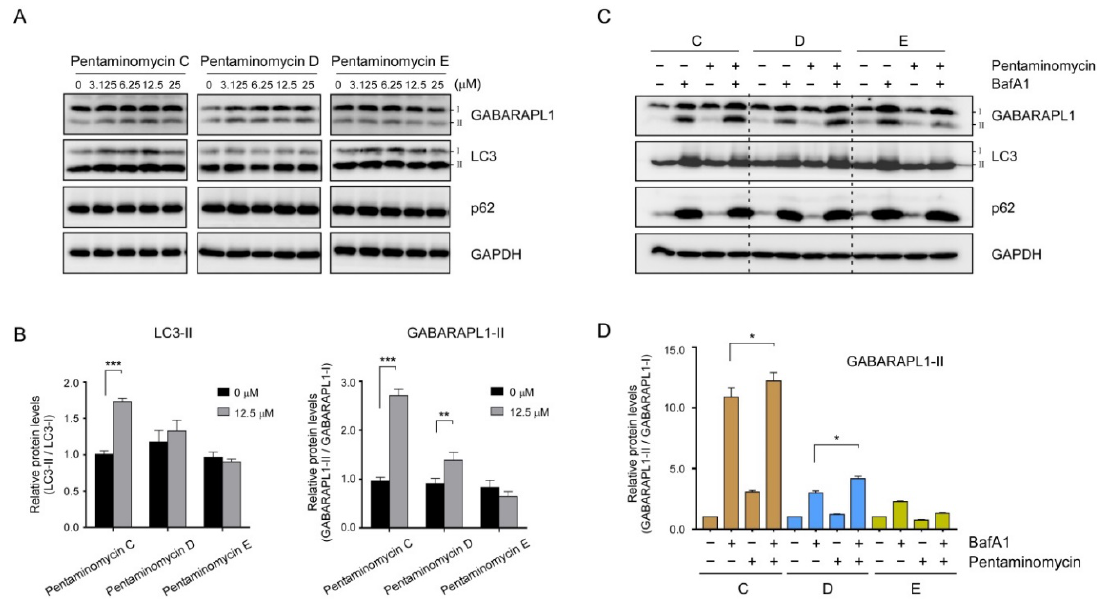
Figure 4. Effects of pentaminomycins C–E ( 1 – 3 ) on cellular autophagy in mammalian cells. HEK293T cells were treated with various concentrations of pentaminomycins for 8 h. ( A ) Whole cell lysates were harvested and subjected to SDS-PAGE followed by immunoblotting against the indicated antibodies. ( B ) Quantification of LC3-II and GABARAPL1-II in the presence of pentaminomycins (12.5 µ M) using the multiple immunoblot images. Data were normalized to those of non-lipidated proteins. Data represent mean ± SD from three independent experiments. **, p < 0.01 and ***, p < 0.001 (one-way analysis of variance (ANOVA) with Bonferroni’s multiple comparison test). ( C ) Pentaminomycins C and D, but not E, induce global cellular autophagy. HEK293T cells were cotreated with pentaminomycins C–E (20 µ M) and a downstream autophagy inhibitor bafilomycin A1 (BafA1; 100 nM) for 12 h. ( D ) Quantification of GABARAPL1-II normalized to GABARAPL1-I in the presence or absence of pentaminomycins and BafA1. *, p < 0.05 (one-way ANOVA with Bonferroni’s multiple comparison test).